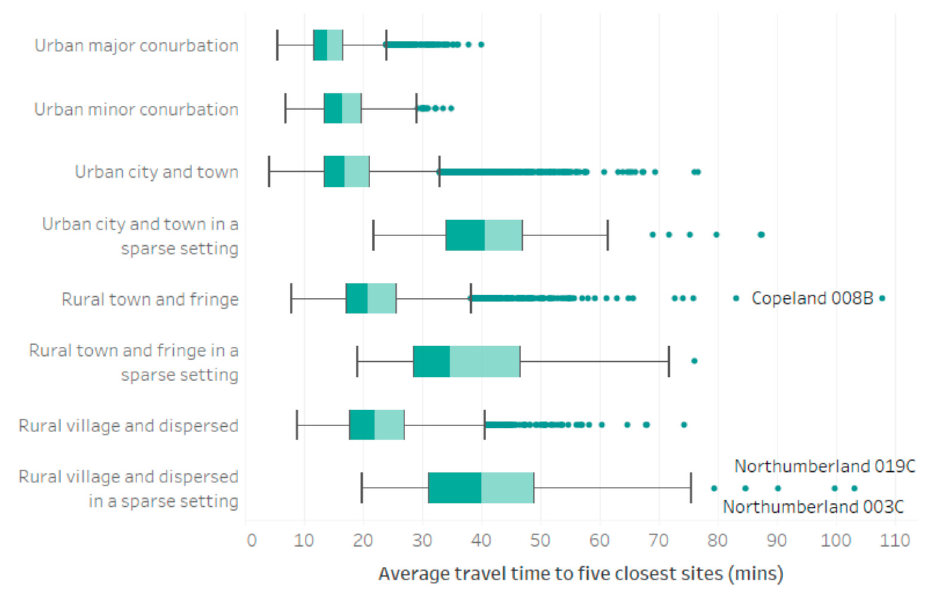
Figure 4. Average journey times to five closest vaccination sites (accounting for both private and public transport, weighted according to inferred usage), grouped by rural ‐ urban classification at the LSOA